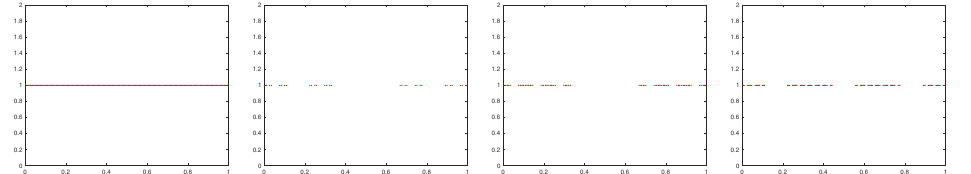
Figure 4. Attractors generated by the multiple-function system F 1 (cid:101) with (cid:101) = ( 0,0,0,0,0 ) , (1,1,1,1,1), (1,0,1,0,1), (0,1,0,1,0) (from left to